Question: Express in one sentence what the figure is showing.
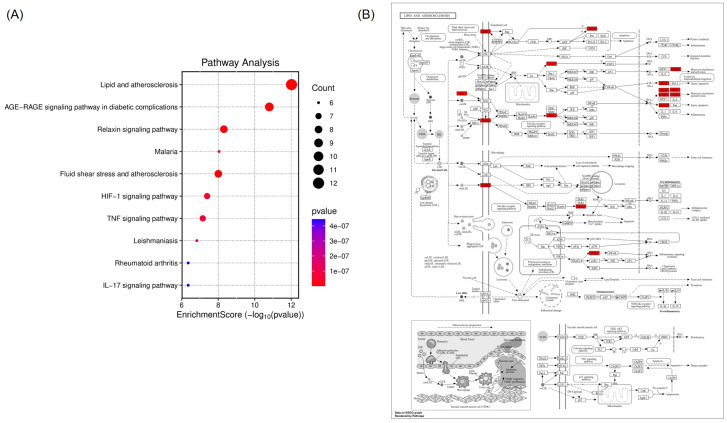
Answer: KEGG analysis of key targets of TGP and colchicine in treatment of BD. (A) Bubble plot of top 10 KEGG pathways. (B) Reprinted of Lipid and atherosclerosis signaling pathway download from the Microbioinformatics platform.